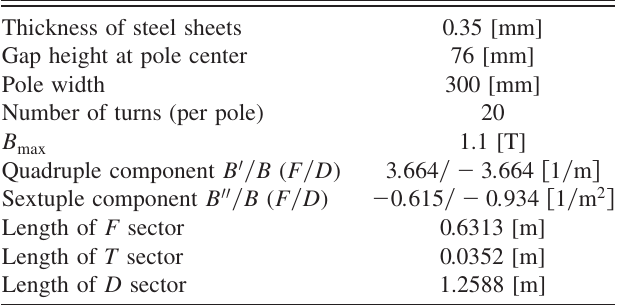
TABLE III. Parameters of main magnets. Thickness of steel sheets